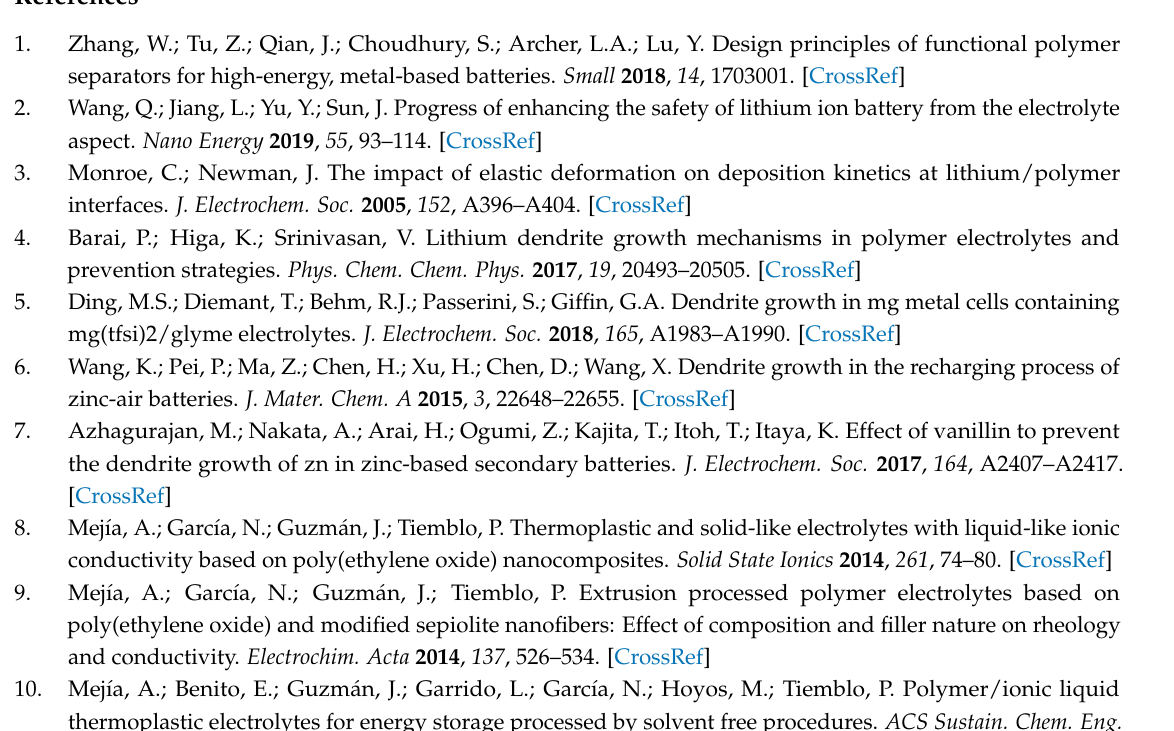
Figure S1: FTIR spectra in the 700 to 1500 cm − 1 region illustrating the crystallization forms of polyvinylidene fluoride–hexafluoropropylene (PVDF–HFP) and the electrolyte composition. Figure S2: Gravimetric determination of the liquid phase loss in two electrolytes along time. Figure S3: (a) Differential Scanning Calorimetry (DSC) on cooling at 10 ◦ C · min − 1 showing the crystallization of the electrolytes and (b) DSC on heating at 10 ◦ C · min − 1 showing the Tg and Tm of the electrolytes, divided into two groups for better visualization. Figure S4: FTIR spectrum of PVDF–HFP in DMF solution, 1 wt %. Figure S5: Strain–stress curves of all the electrolytes. They have been divided into two groups for better